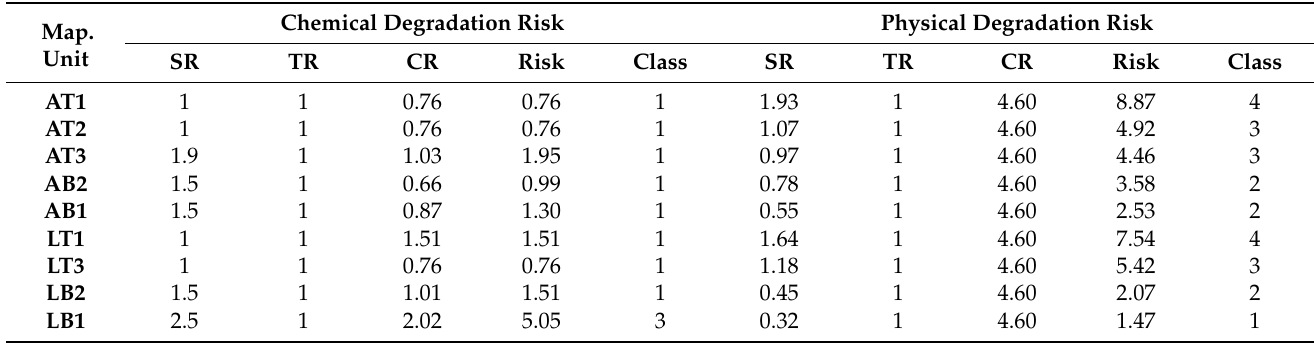
Table 5. The computed chemical and physical degradation risks in the studied area.